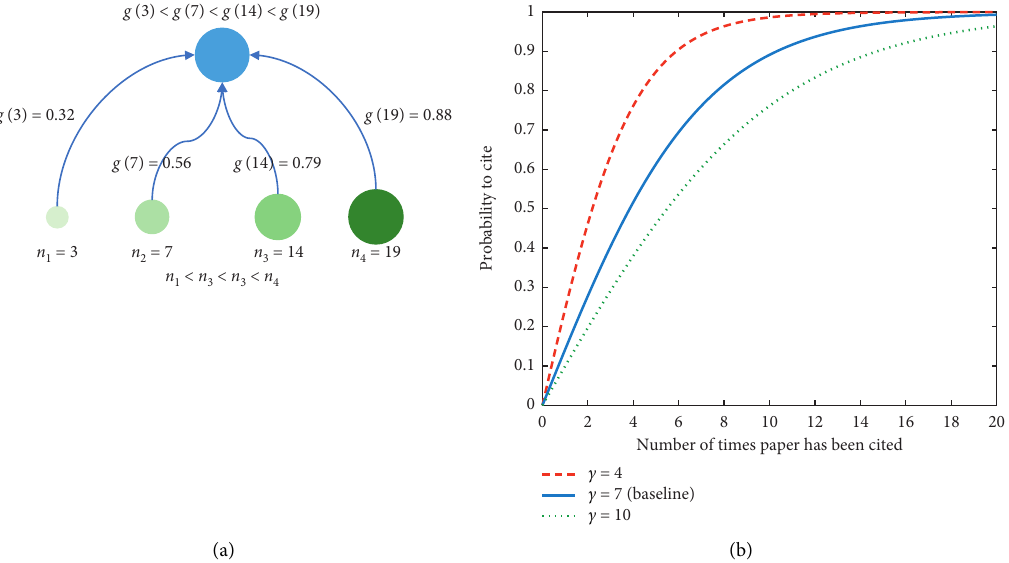
Figure 5: Relation between the number of citations already achieved ( n ) and the effect to probability of a paper to be cited. (a) Sketch of the number of citations a paper receives ( n ). (b) g ( n ) � tanh ( n / c )